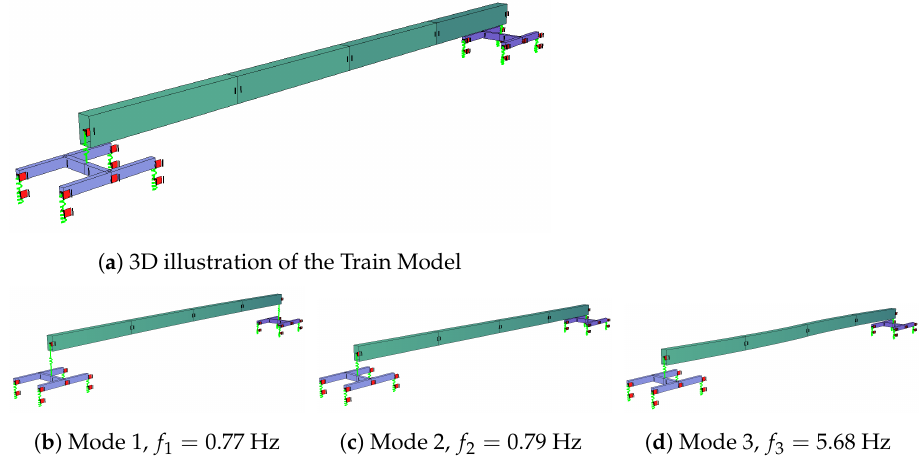
Figure 4. Numerical model of the train and its mode shapes.